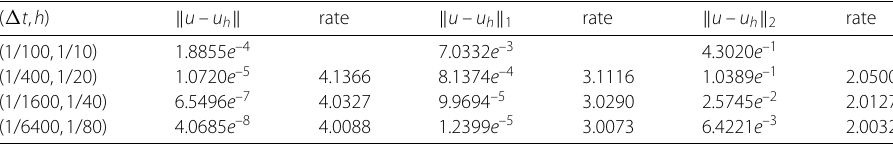
Table 3 The errors for different time step (cid:3) t and space step h at t = 1 and convergence